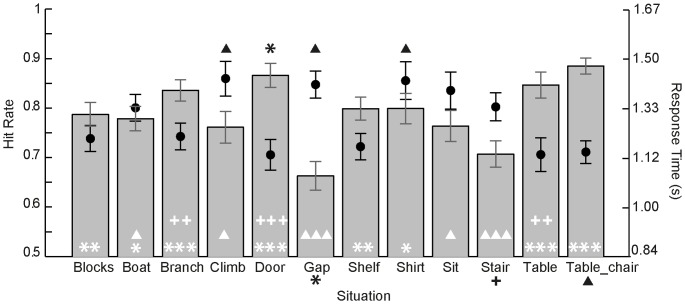
Response characteristics per situation in P2-help.Hit rates (bars) and mean RTs (dots) were calculated across all variations of a given situation. Symbols indicate significant differences in hit rates (white symbols) and RTs (black symbols). The number of symbols corresponds to p-values of post-hoc Tukey HSD tests (one: p<.05, two: p<.01, three: p<.001). Asterisks mark significant differences compared to the situation “gap”, triangles to “table_chair” and crosses to “stair”. Error bars represent SEM. Note that differences are only indicated once for each pair of situations.